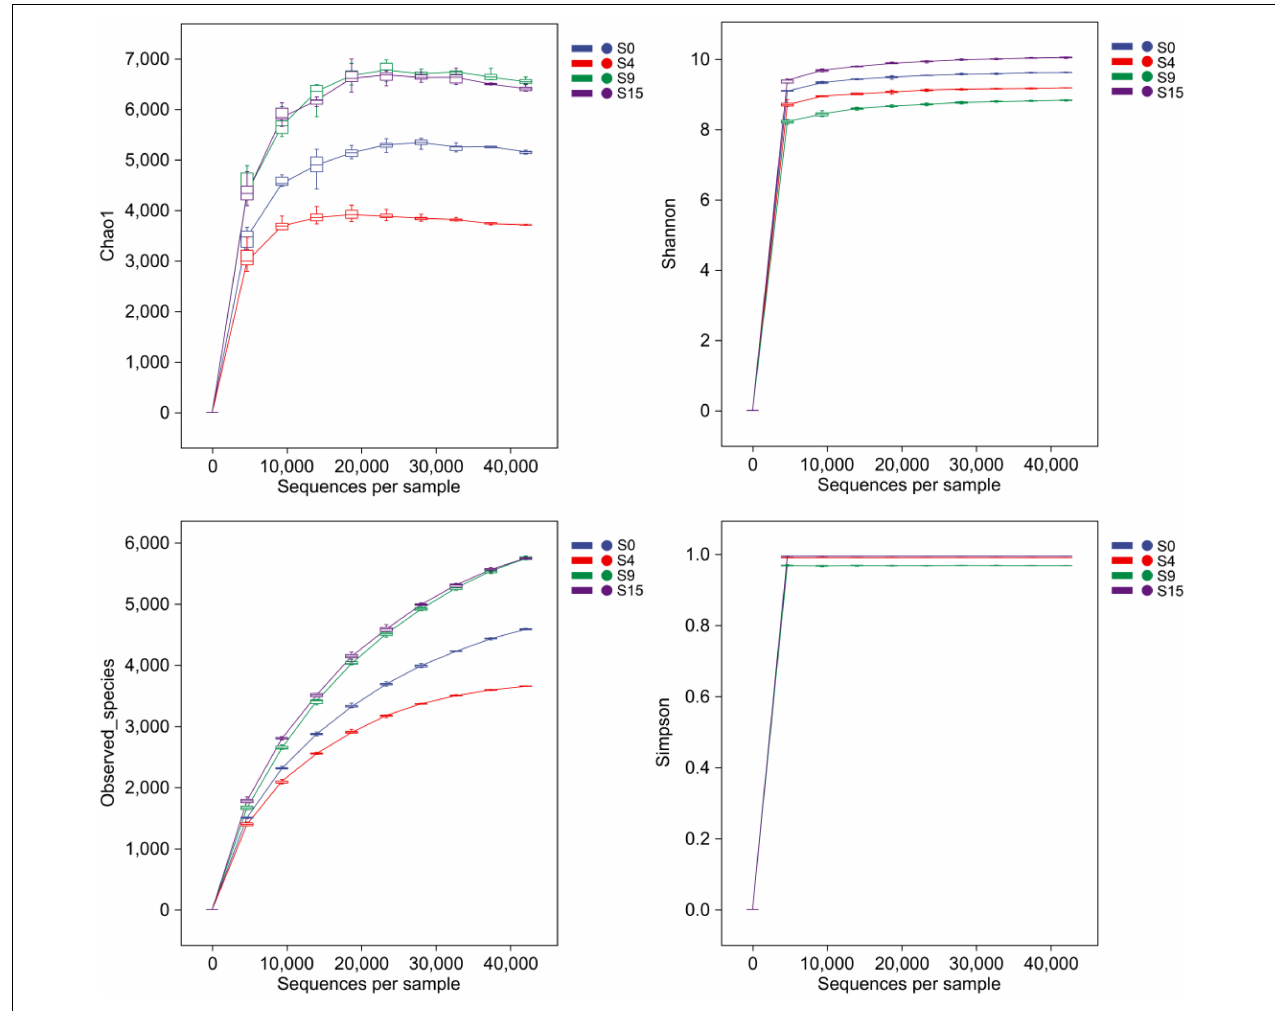
FIGURE 8 | Alpha diversity